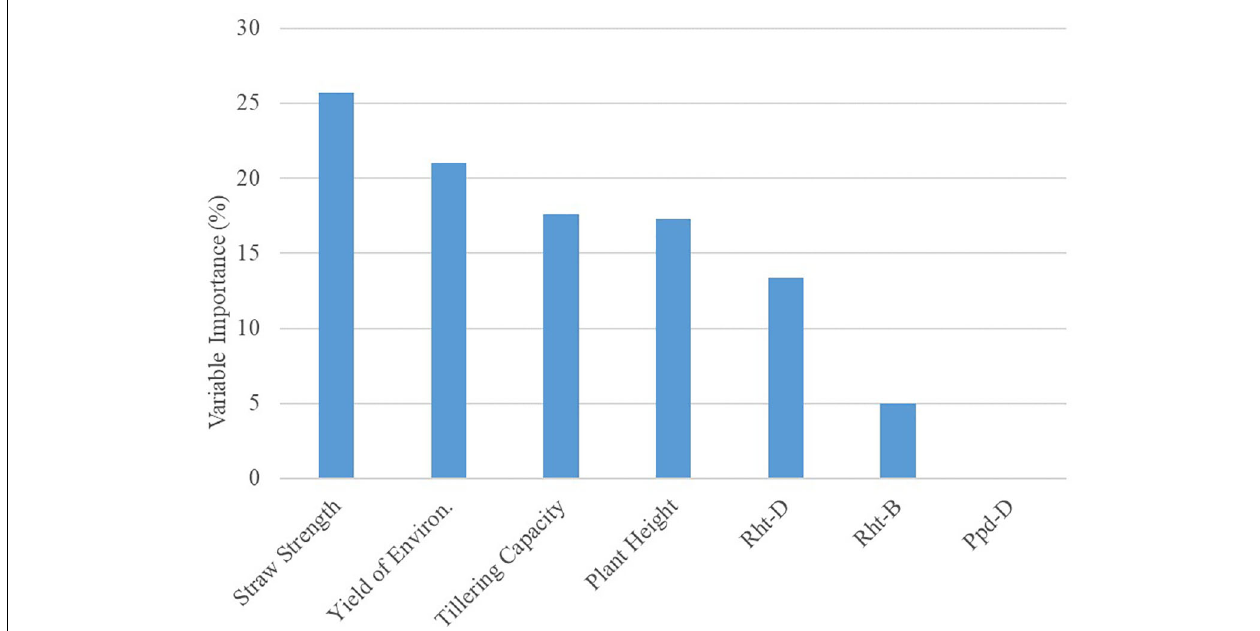
FIGURE 2 | Results for Variable Importance output from decision tree model analyzing seeding rate dataset ( n = 351) in R . Importance is relative to 100%.